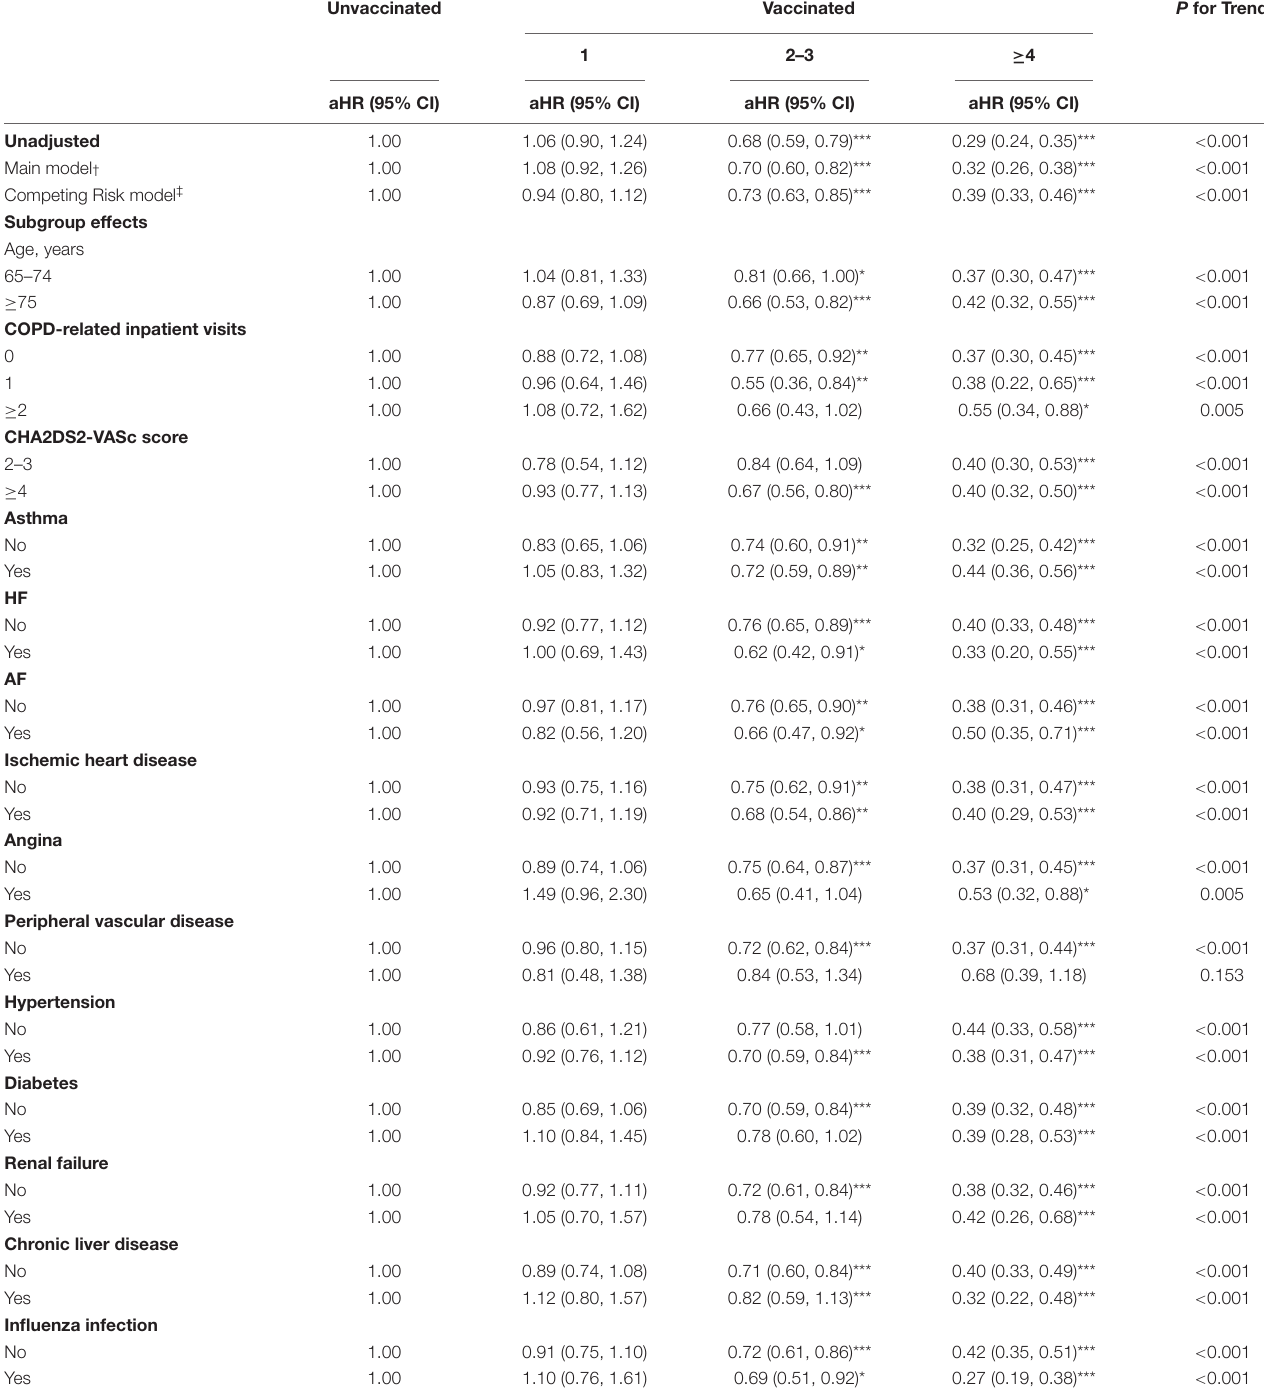
TABLE 3 | Sensitivity analysis of the adjusted hazard ratios of vaccination in stroke risk reduction. Unvaccinated